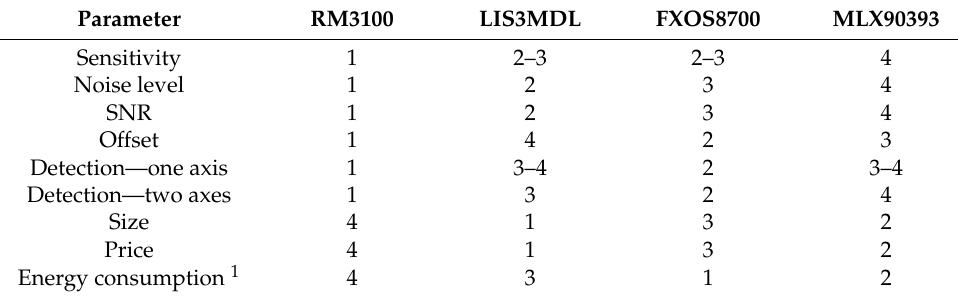
Table 10. Summary of the achieved